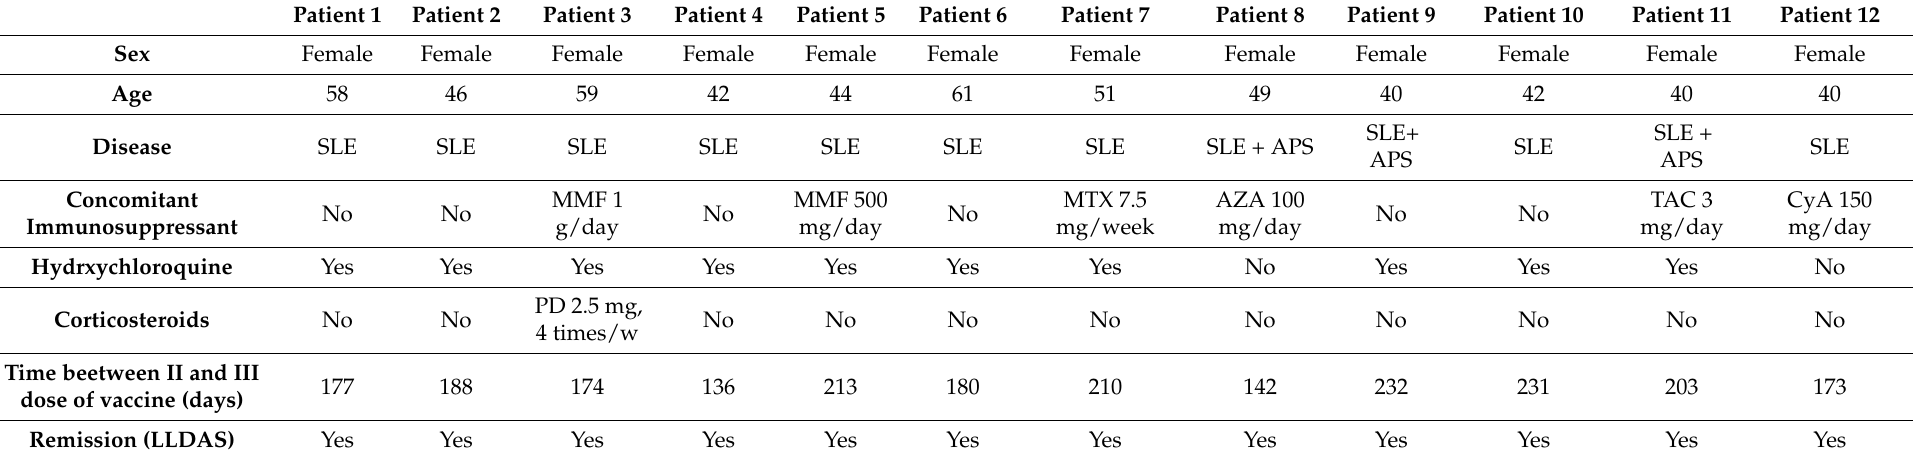
Table 1. Characteristics and immune response of the